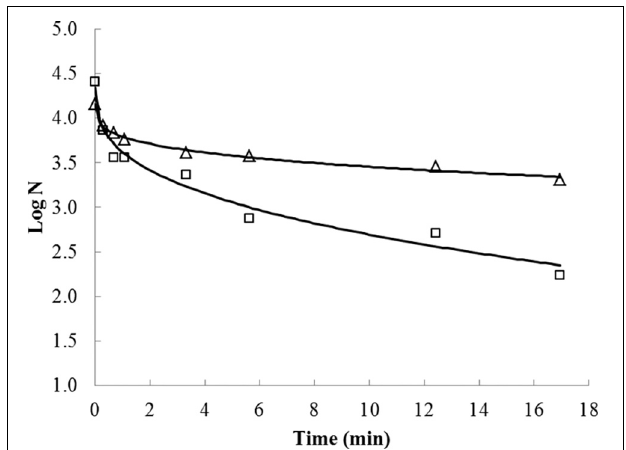
FIGURE 1 | UV-C treatment effects on Salmonella Typhimurium inactivation on dry-fermented sausages. Fitting of the Weibull model (lines) to the observed S. Typhimurium inactivation data corresponding to non-habituated (squares) and habituated (triangles) cells exposed to UV-C radiation